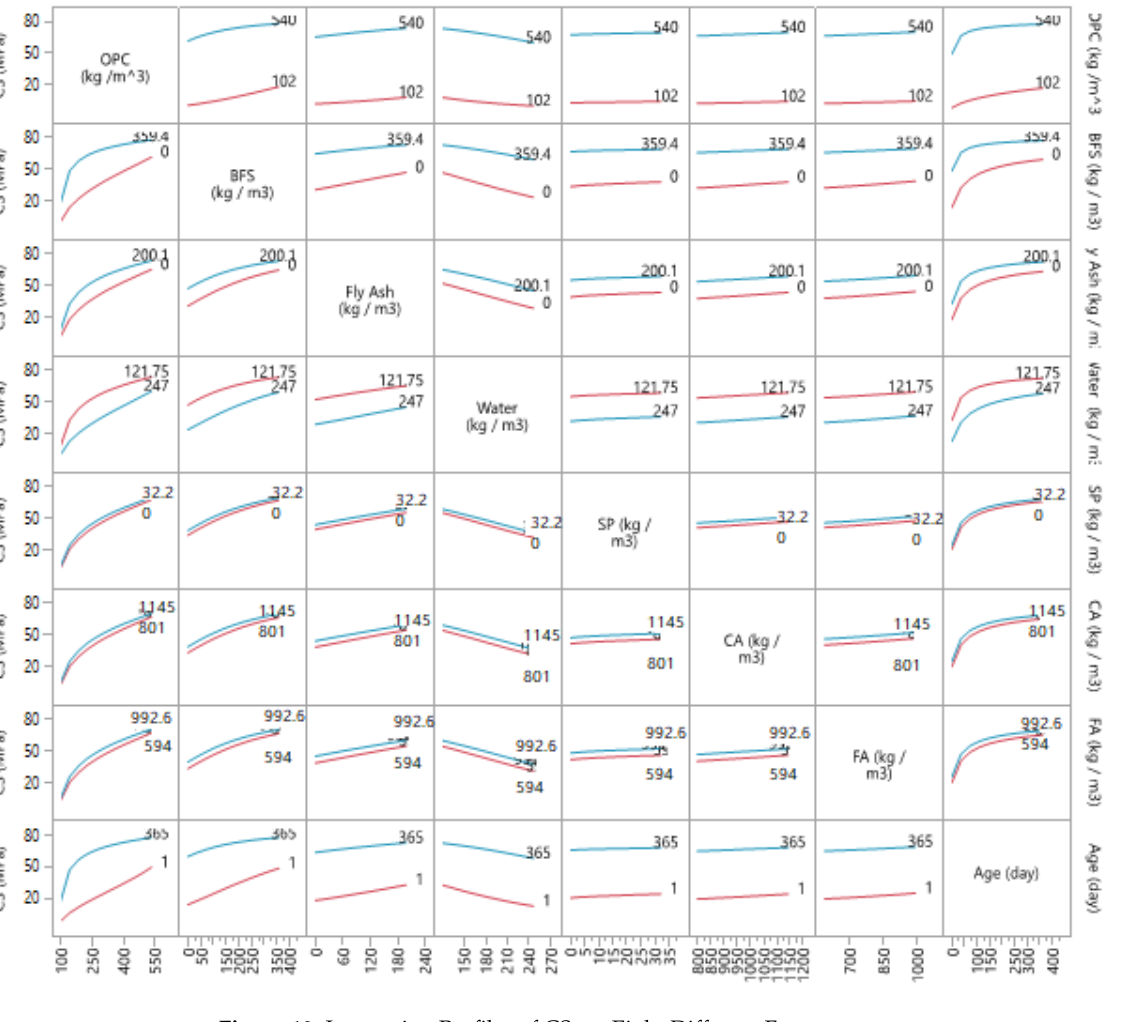
Figure 10. Interaction Profiler of CS vs. Eight Different Factors.